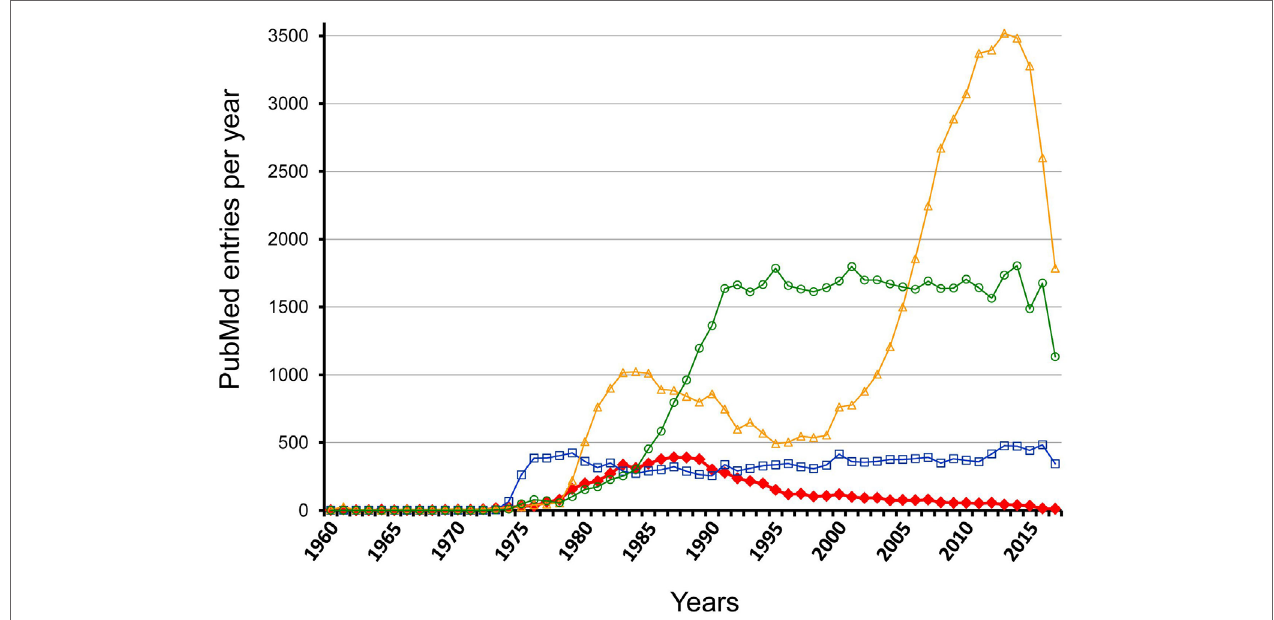
FiGURe 1 | Comparison of PubMed entry “ idiotype ” with related marks per year between 1960 and 2017. The figure shows the results of a PubMed search for the following keywords: idiotype—red filled rhombus; regulatory T cell—yellow open triangles; B cell antigen receptor—blue open squares; T cell antigen receptor—light green open